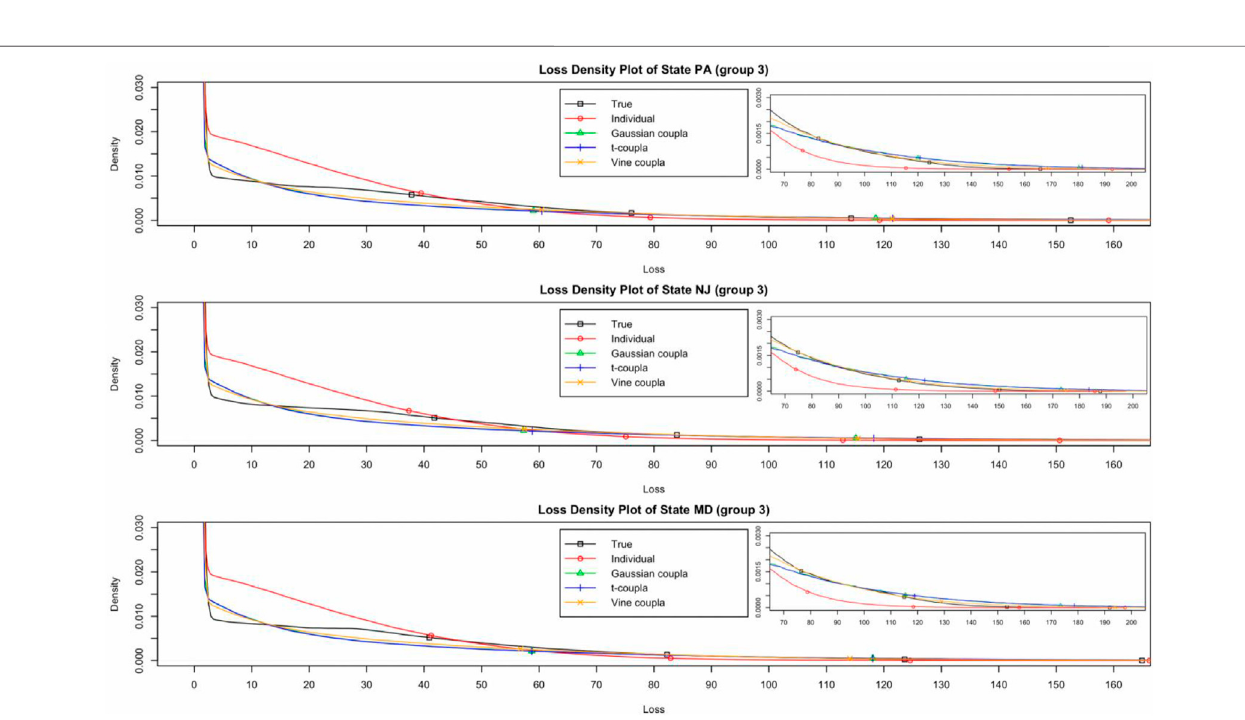
Frontiers in Environmental Science |